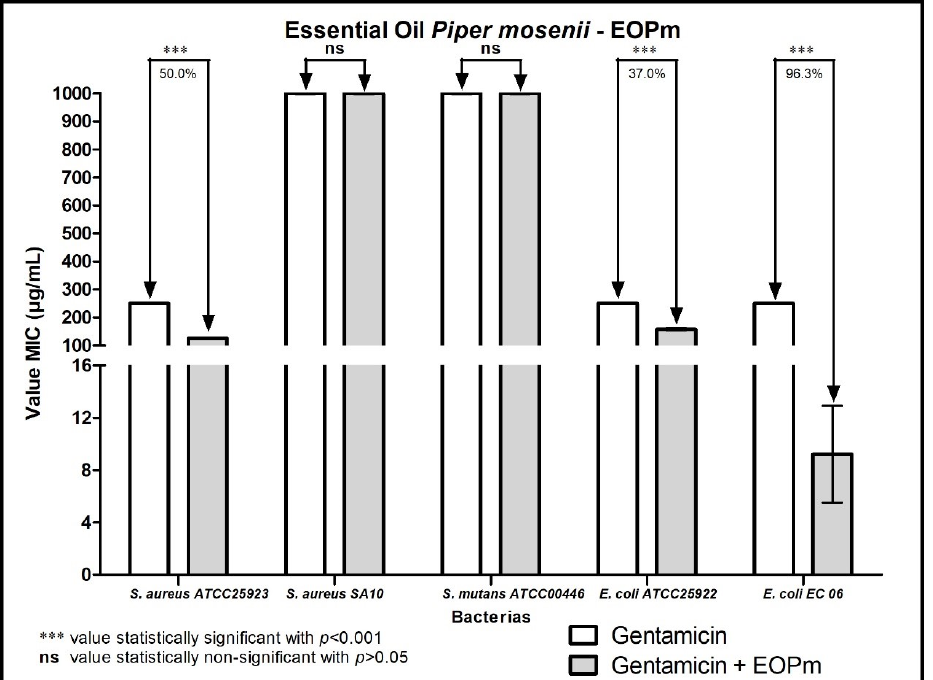
Figure 4. Evaluation of the modulatory activity of EOPa combined with Gentamicin against bacterial strains.